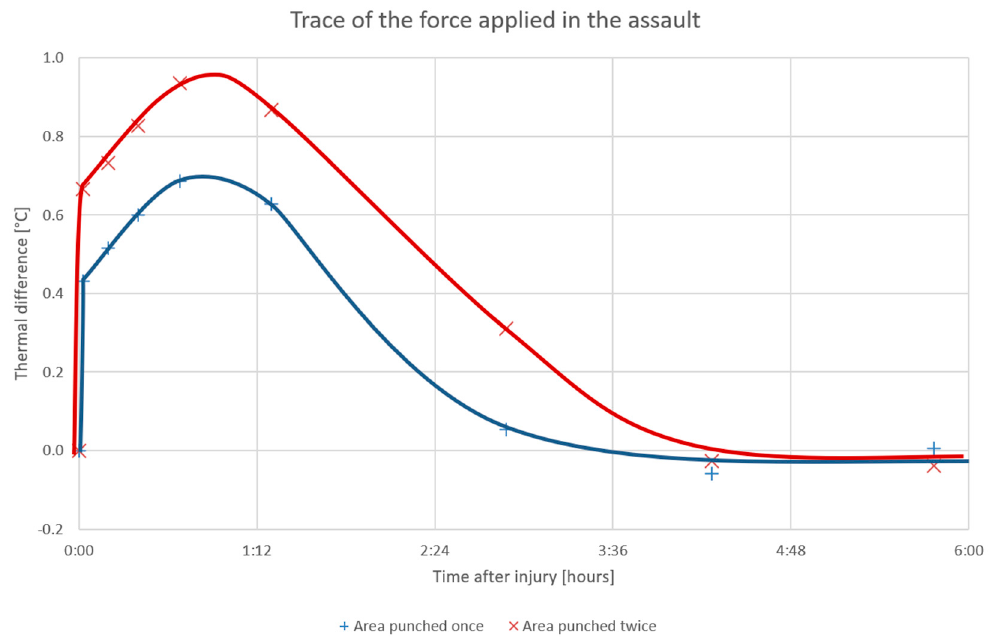
Figure 13. The thermal differences relating to the initial conditions and their progress during the first 6 h after the simulated assault; the subject was punched at t = 0:00.